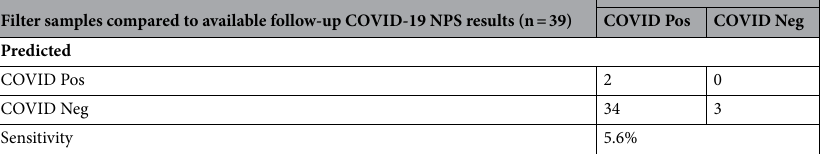
Filter samples compared to available follow-up COVID-19 NPS results (n =